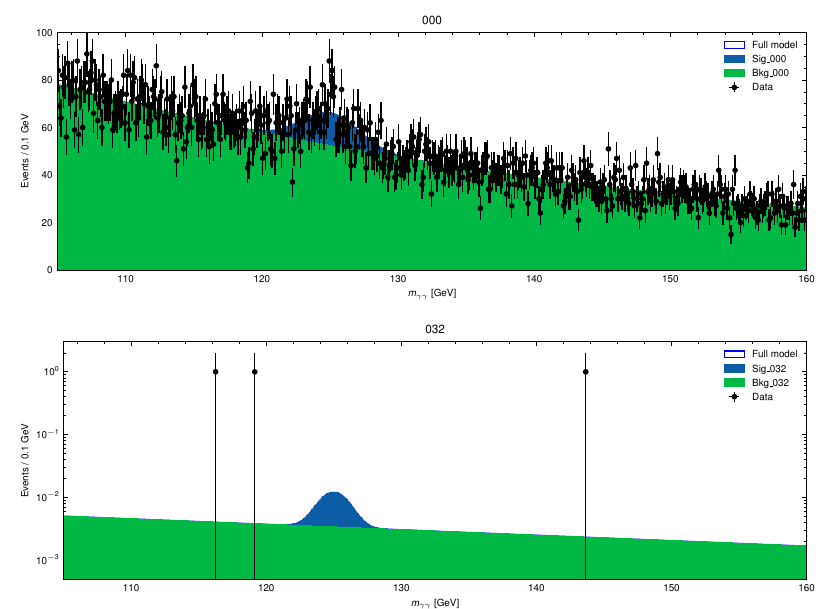
Figure 6 . Distributions of the observable m γγ for two selected categories — the ones labeled 0-jet, p H < 10 GeV (top) and p H ≥ 650 GeV (bottom) in ref. [21]. The bin width is 0 . 1 GeV in both T T cases. The signal and background contributions (blue and green histograms respectively) are shown together with the example dataset (black points), for the best-fit value of the model